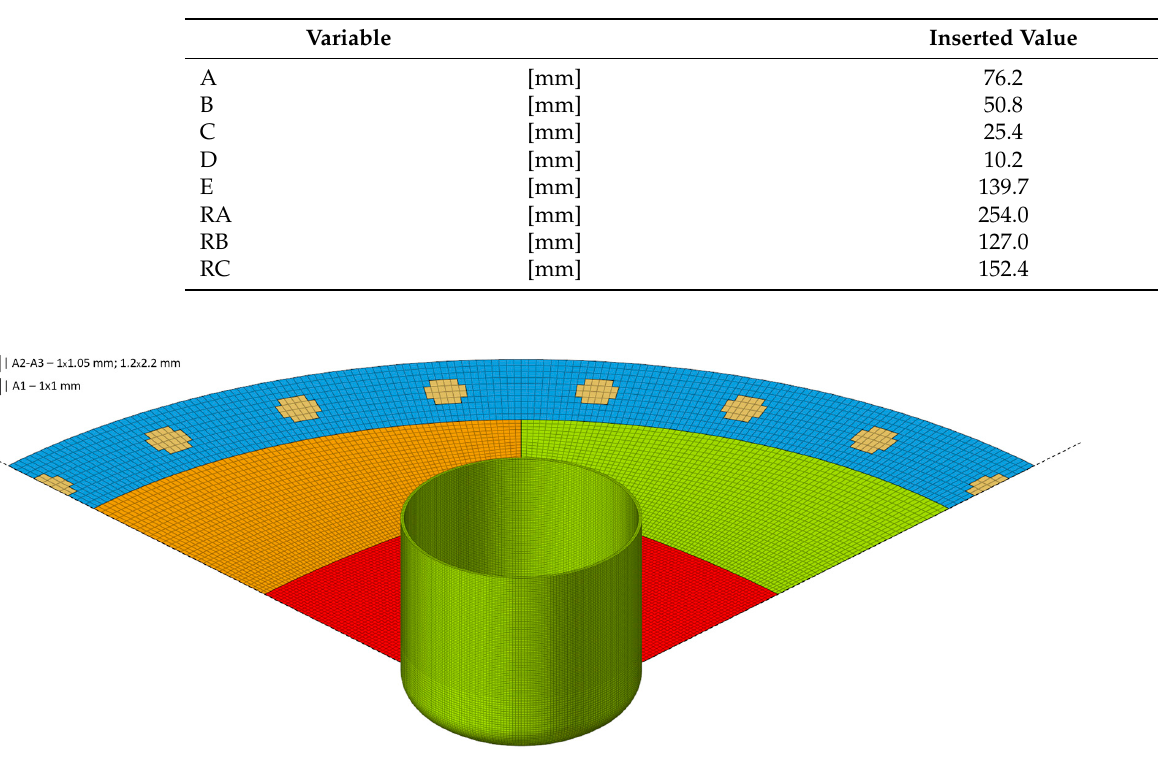
Figure 6. Details of mesh-size region in the composite fl at plate.